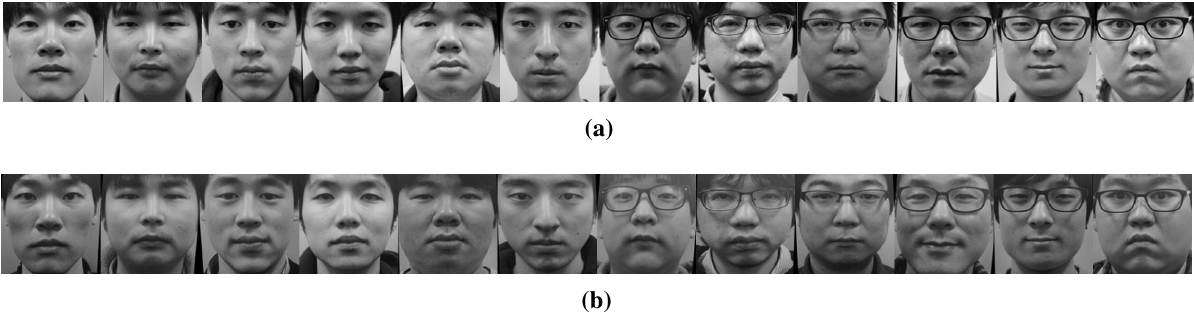
Figure 20. Normalized images of ( a ) real and ( b ) fake faces.